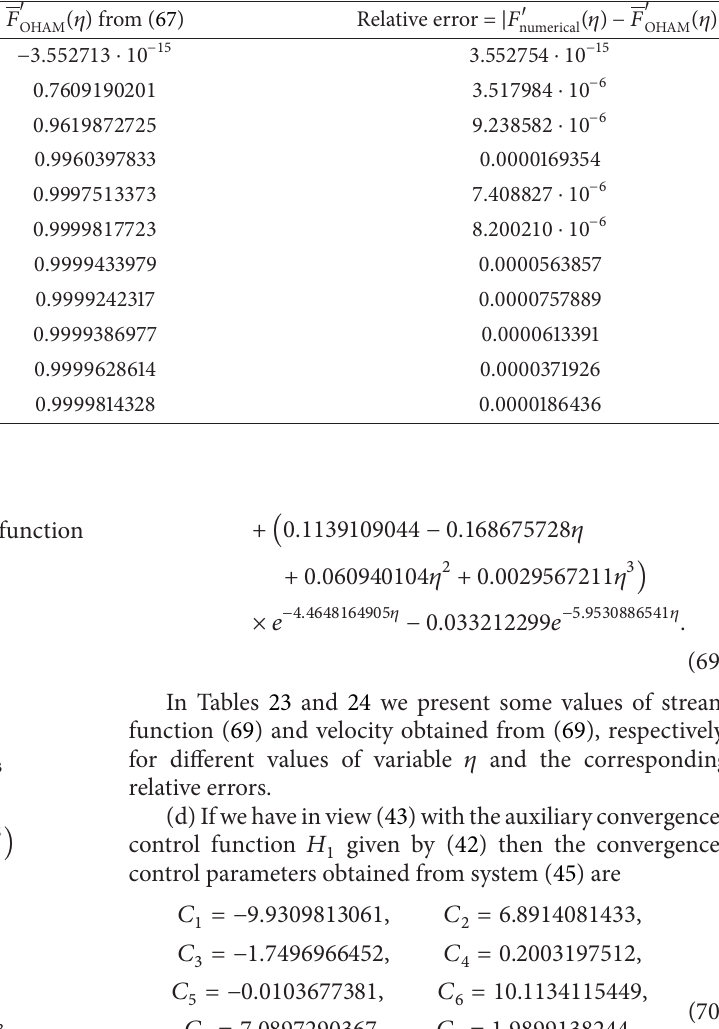
Table 22: Comparison between OHAM results for velocity 𝐹